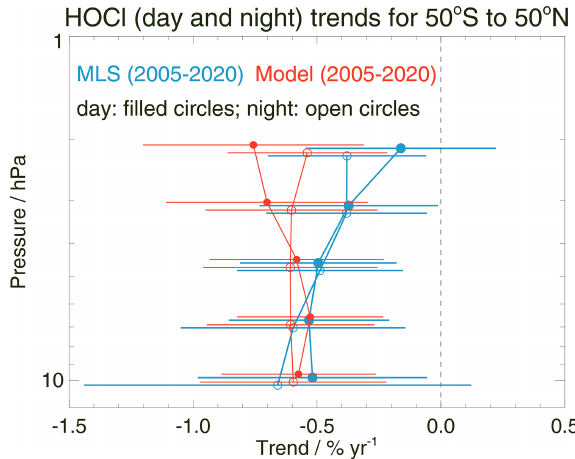
Figure 9. Same as Fig. 5 except for trend results for HOCl from both day (filled circles) and night (open circles) time series analyses between 10 and